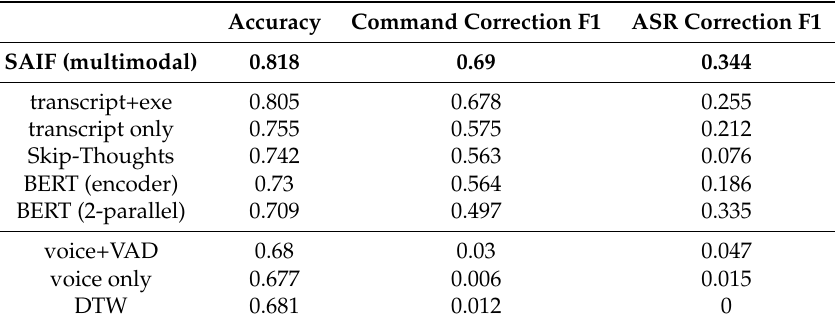
Table 3. Comparison between different